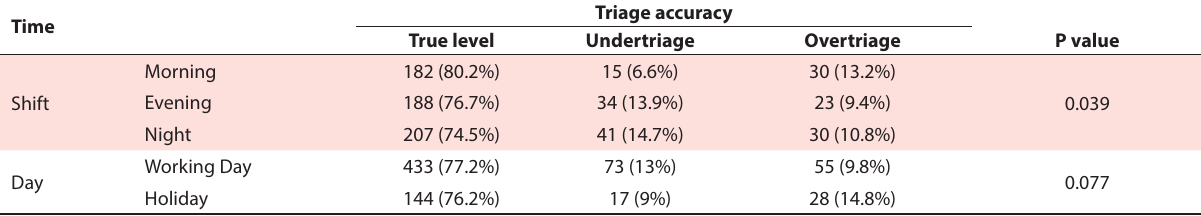
Table 3. Triage error in various work shifts, and working days and holidays